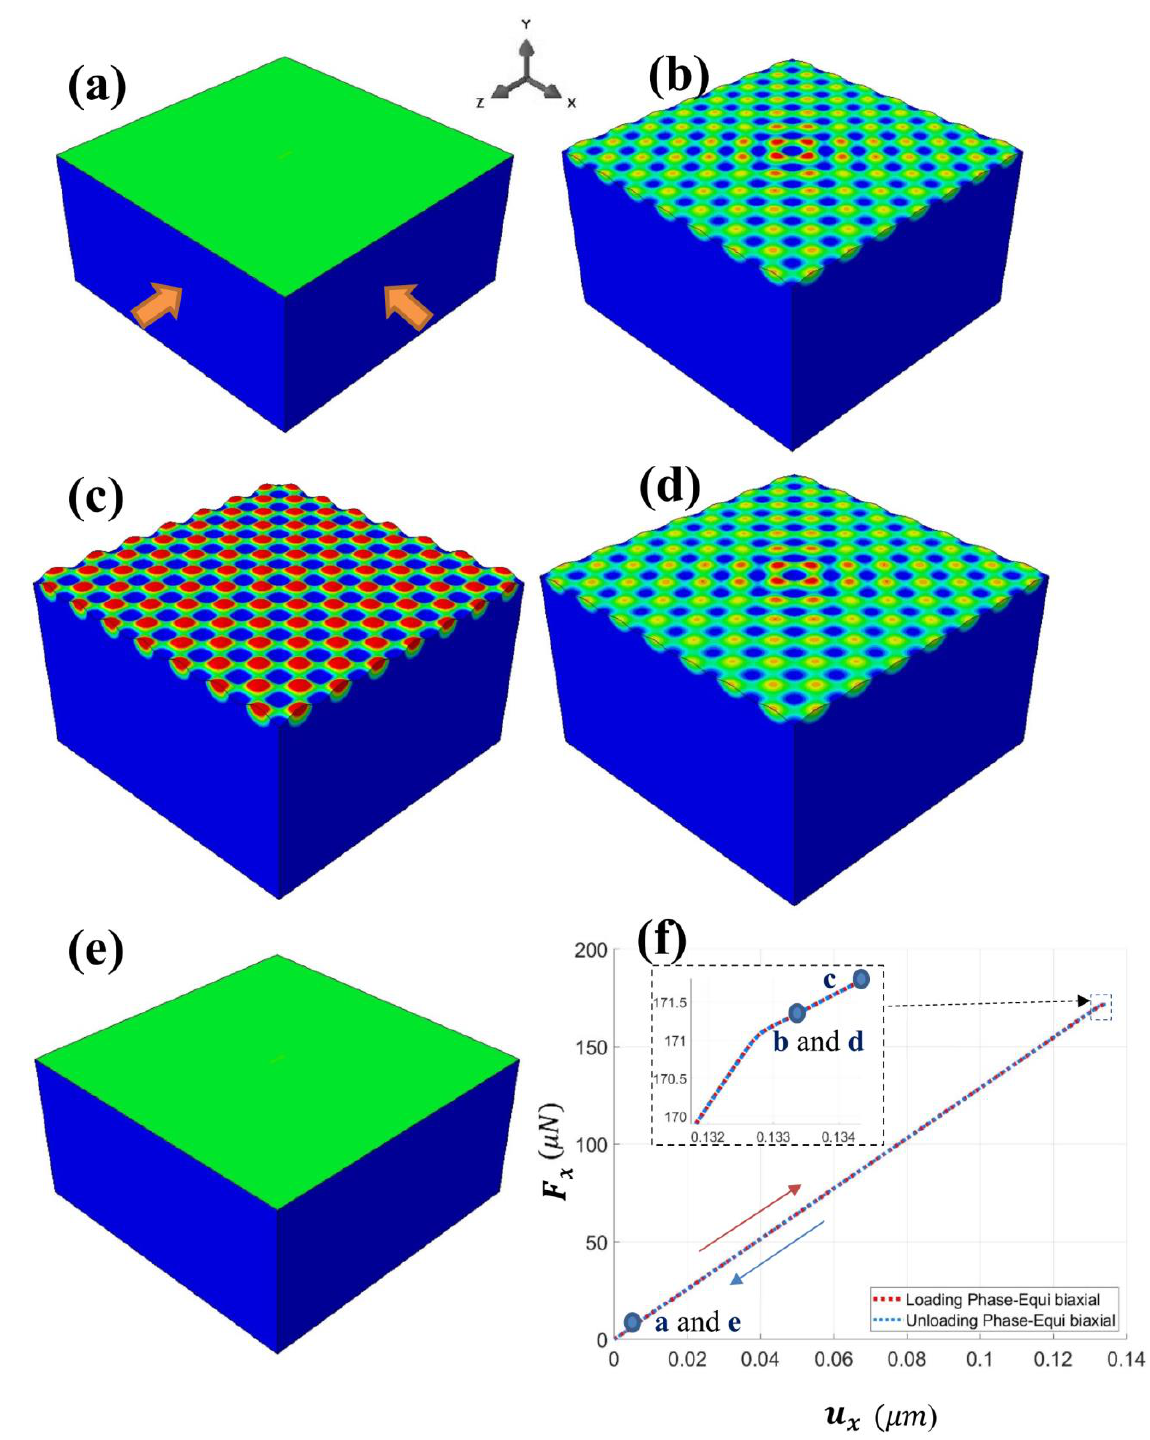
Figure 3. Snapshots of simulated surface pattern during the loading phase (from ( a – c )) and unloading phase (from ( c – e )) of the equi-biaxial compression. ( f ) The overall load – displacement response for the entire deformation history, with the five stages ( a – e ) labeled along the curves.